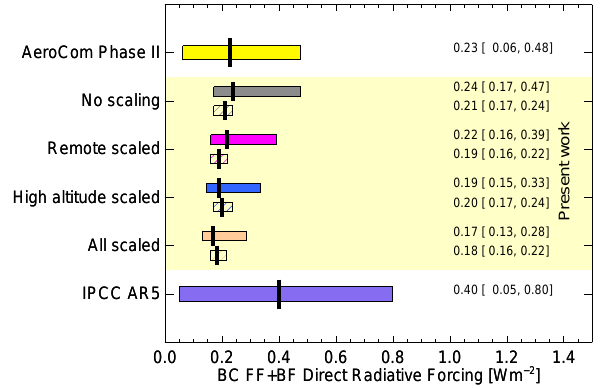
Figure 6. As Fig. 4, except also showing the BC FF + BF forcing from the three models selected based on RMSE and correlation ver- sus HIPPO (hatched